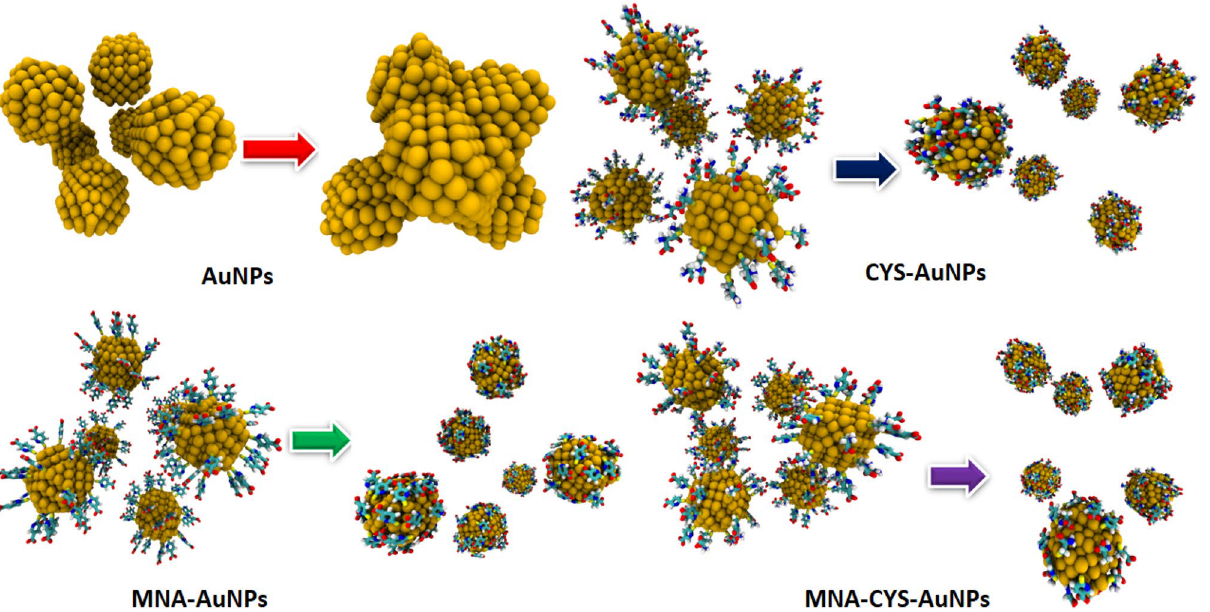
Figure 1. The initial and obtained structures of the pure and functionalized AuNPs after simulation time in